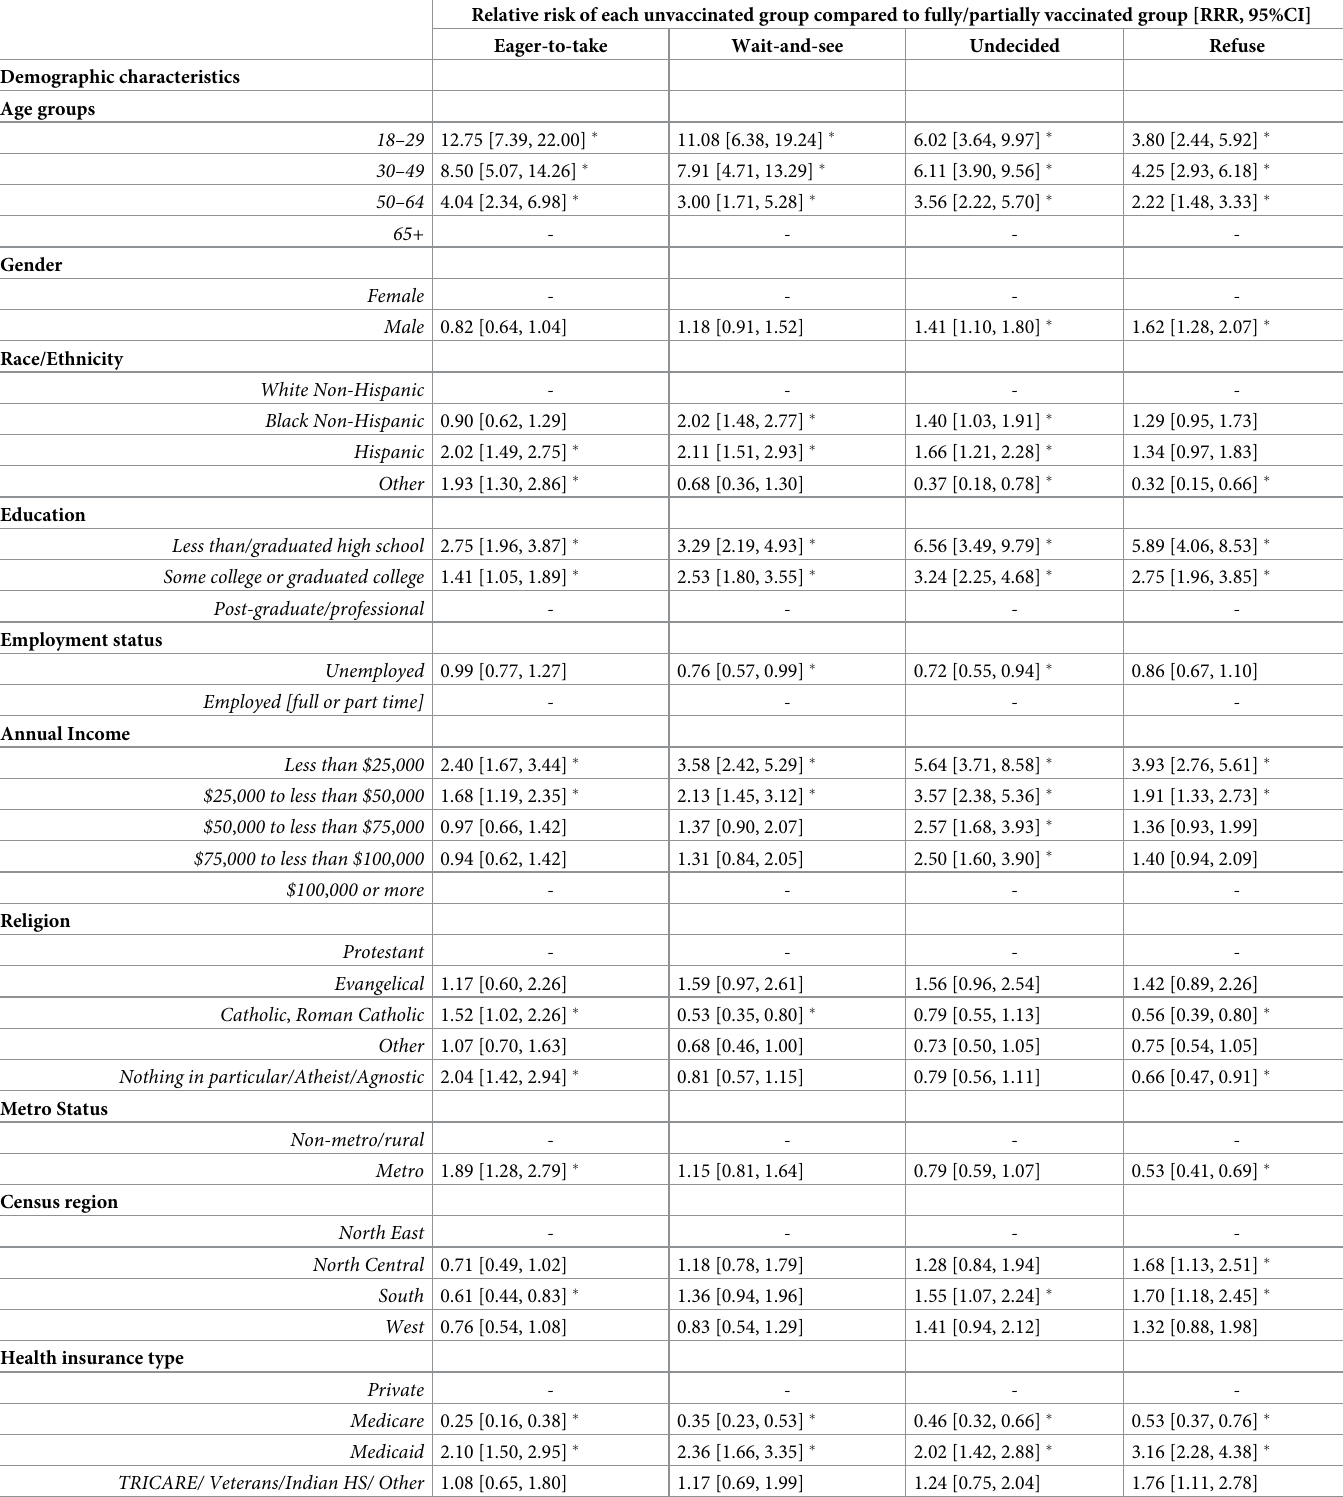
Table 2. Unadjusted multinomial regression of unvaccinated groups compared to fully/partially vaccinated group as a reference category. Relative risk of each unvaccinated group compared to fully/partially vaccinated group [RRR,